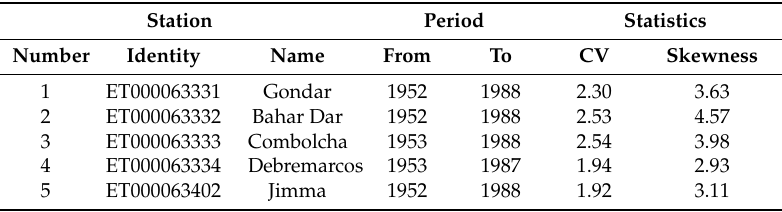
Table 1. Overview of meteorological stations and rainfall